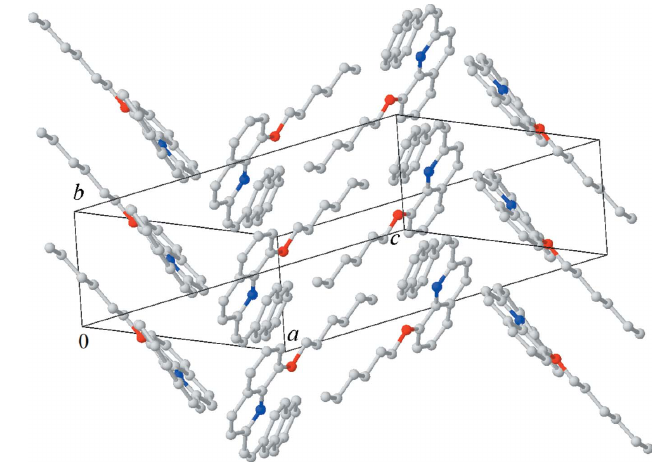
Figure 2 Crystal packing of compound ( 1 ). Hydrogen atoms are omitted for clarity.